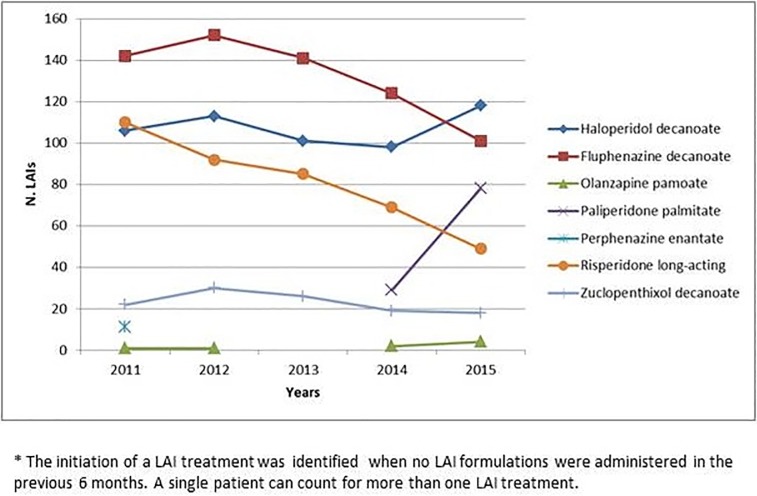
Year-by year initiation of LAI treatments: Trends in prescriptions 2011–2015.